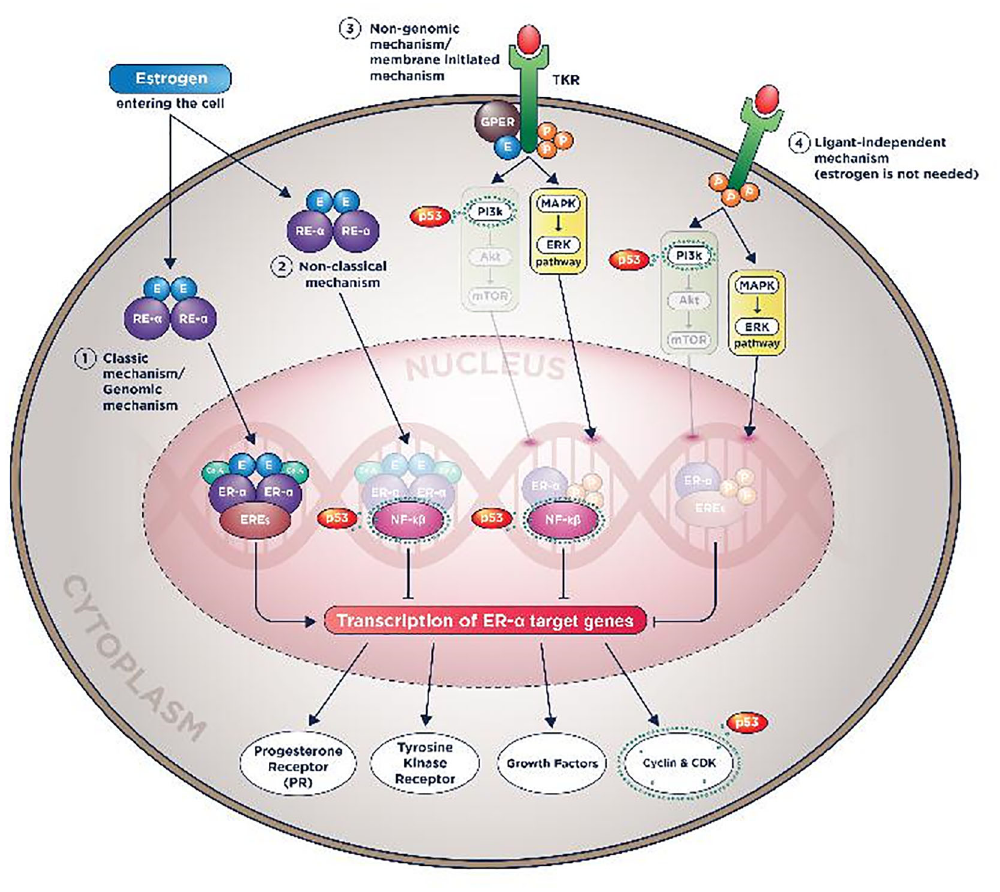
Figure3.Plausiblep53wild-typerolesinreducingendocrinetherapyresistancebyprohibitingER- α molecular